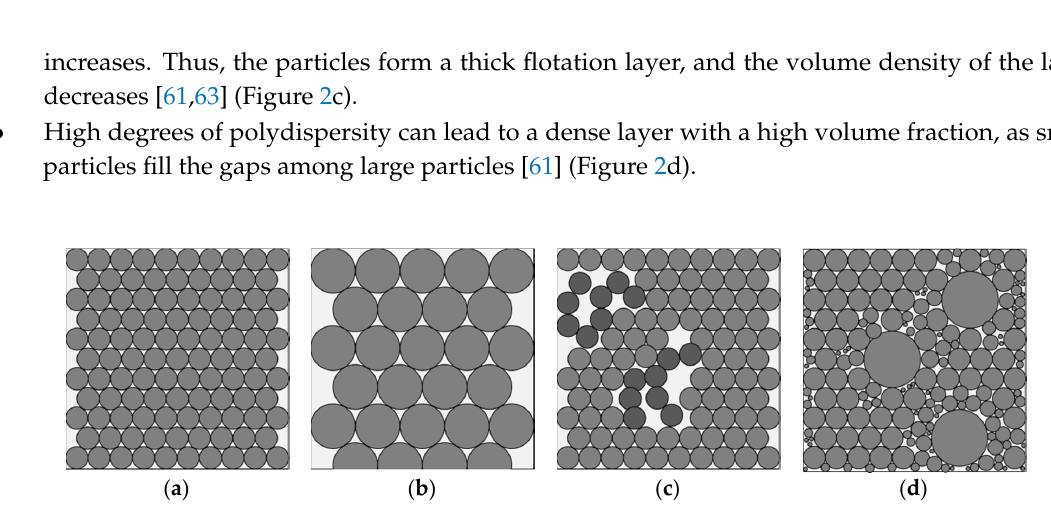
Figure 2. ( a ) Smaller particles with a surface density of 88%; ( b ) larger particles with a surface density of 78%; ( c ) flocculation with a surface density of 82%; ( d ) polydispersity with a surface density of 90%. Although a correlation between the number mean diameter d 1,0 and the ESI, i.e., flotation layer height, was expected, in line with the abovementioned explanation, such an effect was not observed. However, a correlation between d 3,2 and the ESI was observed. As d 3,2 describes the particle volume in relation to the particle surface area, a decrease in the value for d 3,2 suggested an increase in the surface area, i.e., reduced particle sphericity (see Figure 3). The decrease in d 3,2 , i.e., a decrease in sphericity, was expected to lead to a less dense degree of packing, thereby to a thick flotation layer, and finally to a low ESI (positive relationship). However, the Spearman correlation revealed a significantly moderate negative relationship between d 3,2 and the ESI. One possible explanation for this result was that reduced sphericity exerted similar effects as polydispersity (Figure 2d).